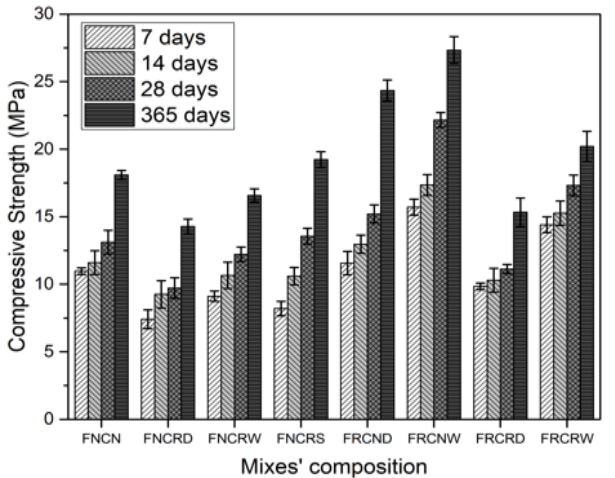
Figure 7. Comparison of the compressive strength of the blocks